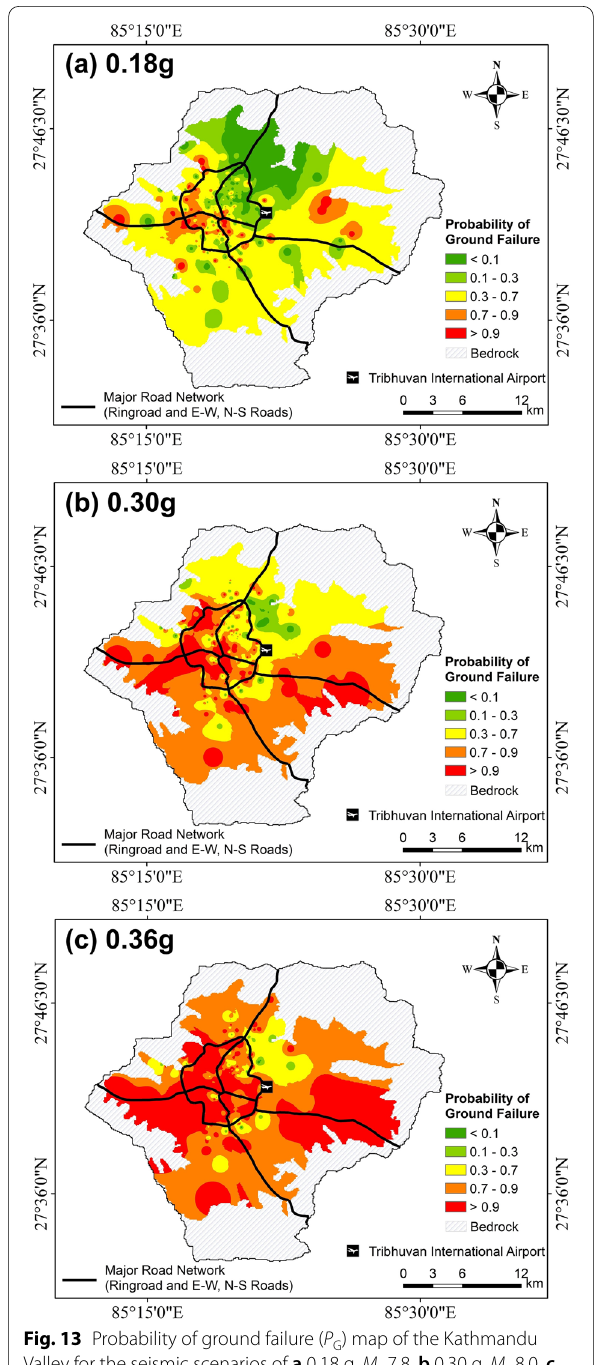
Fig. 13 Probability of ground failure ( P G ) map of the Kathmandu Valley for the seismic scenarios of a 0.18 g, M w 7.8, b 0.30 g, M w 8.0, c 0.36 g, M w 8.4 based on Li et al. (2006)